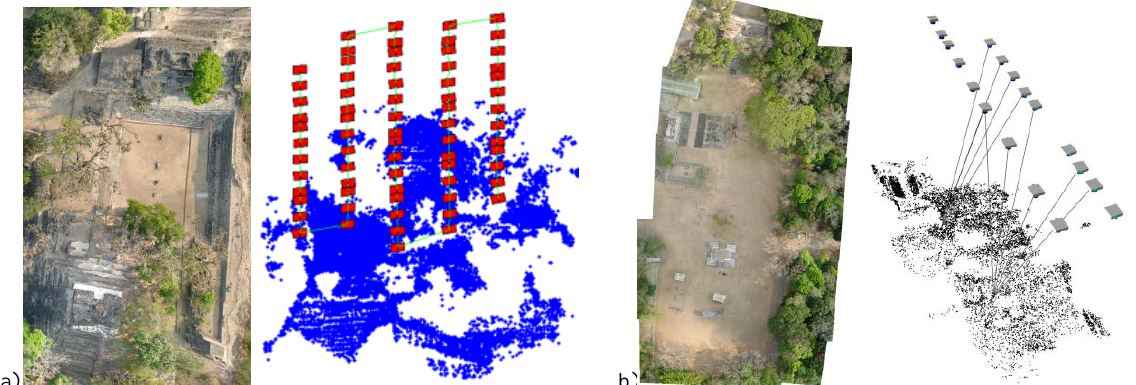
Figure 4: Mosaic of the East Court (a) and Main Plaza (b) in Copan and derived exterior orientation parameters using